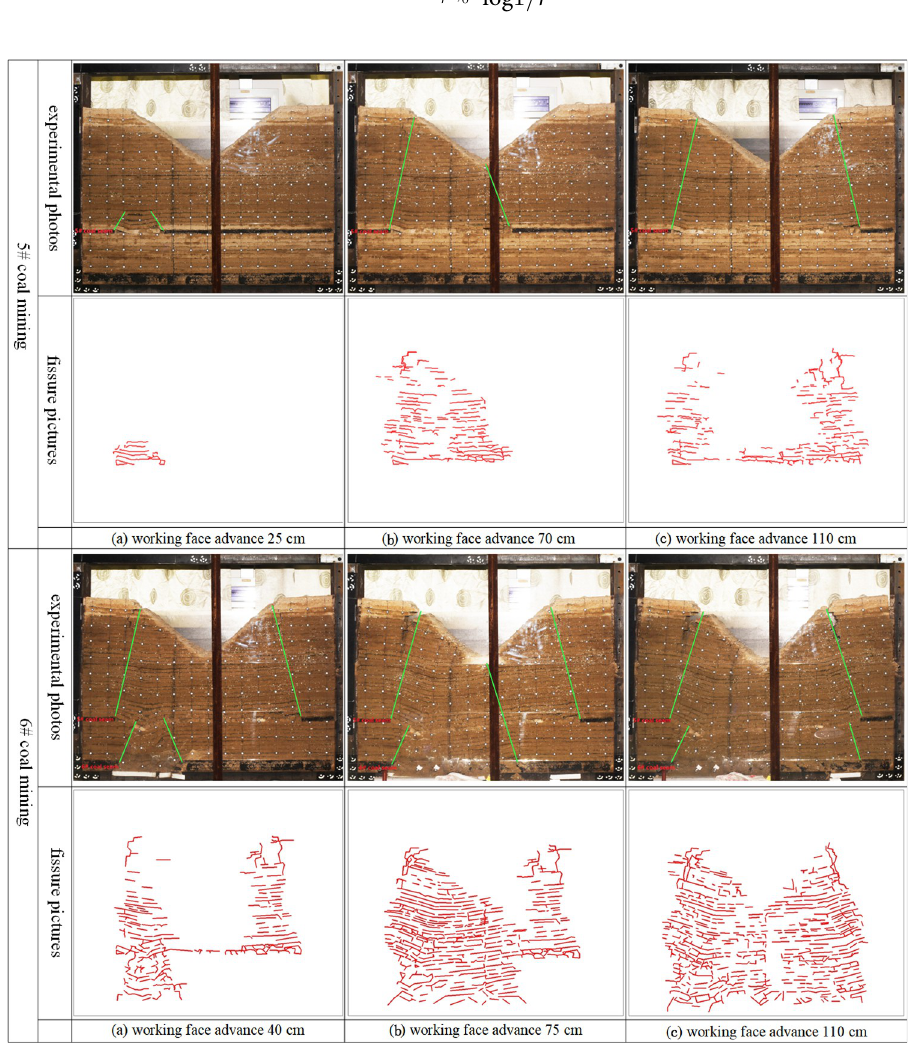
Fig 4. Experimental photos and fissures